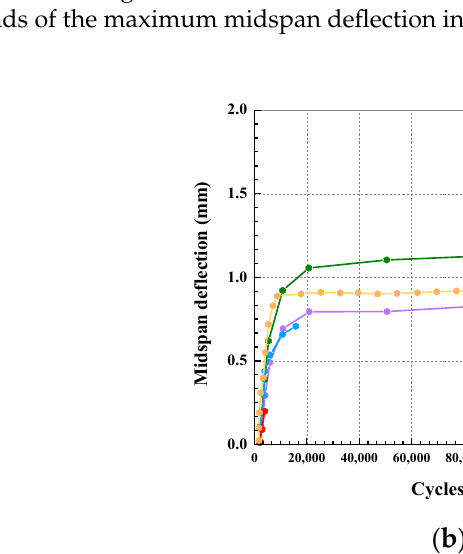
Figure 14. The development of the ( a ) midspan deflection and ( b ) midspan deflection increment during fatigue loading.